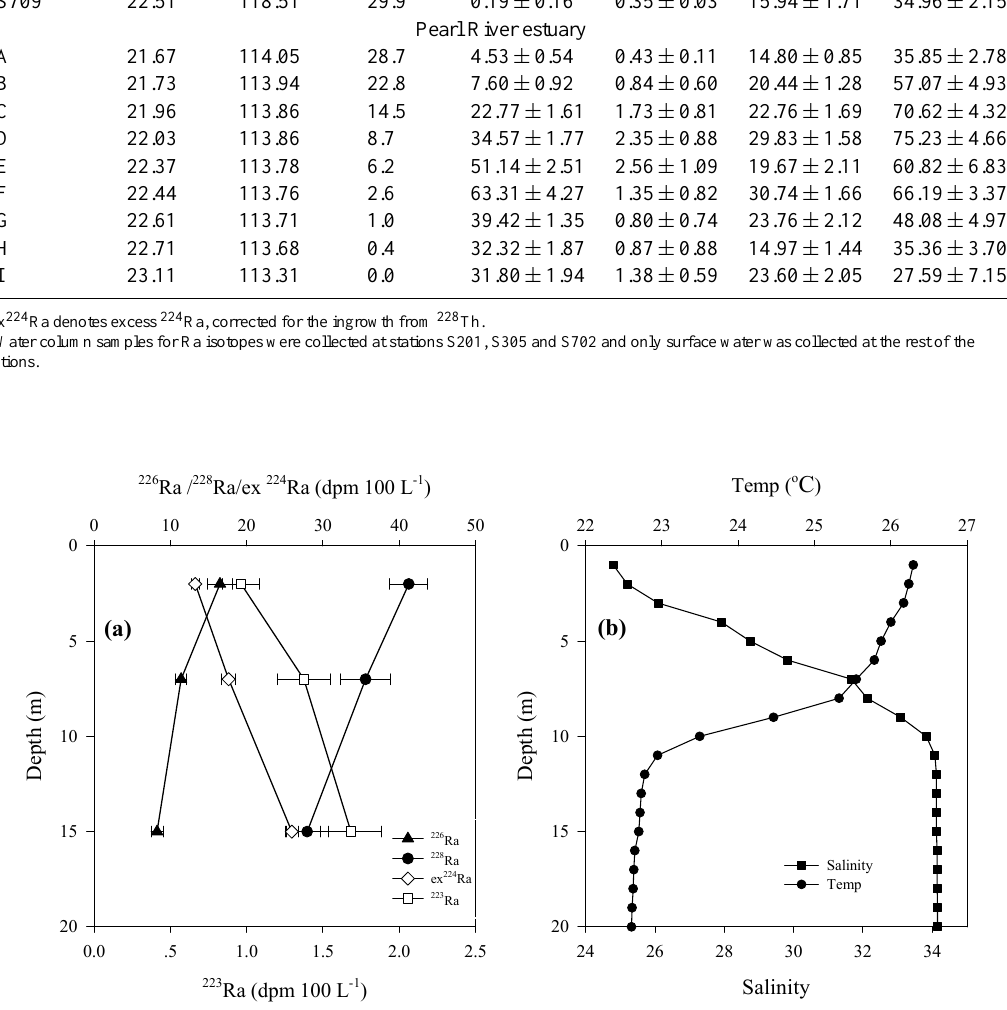
Fig. 4. Vertical profiles of 226 Ra, 228 Ra, ex 224 Ra (excess 224 Ra, corrected for the ingrowth from 228 Th), and 223 Ra (a) and temperature and salinity (b) at S201 located nearest to the shore on Transect